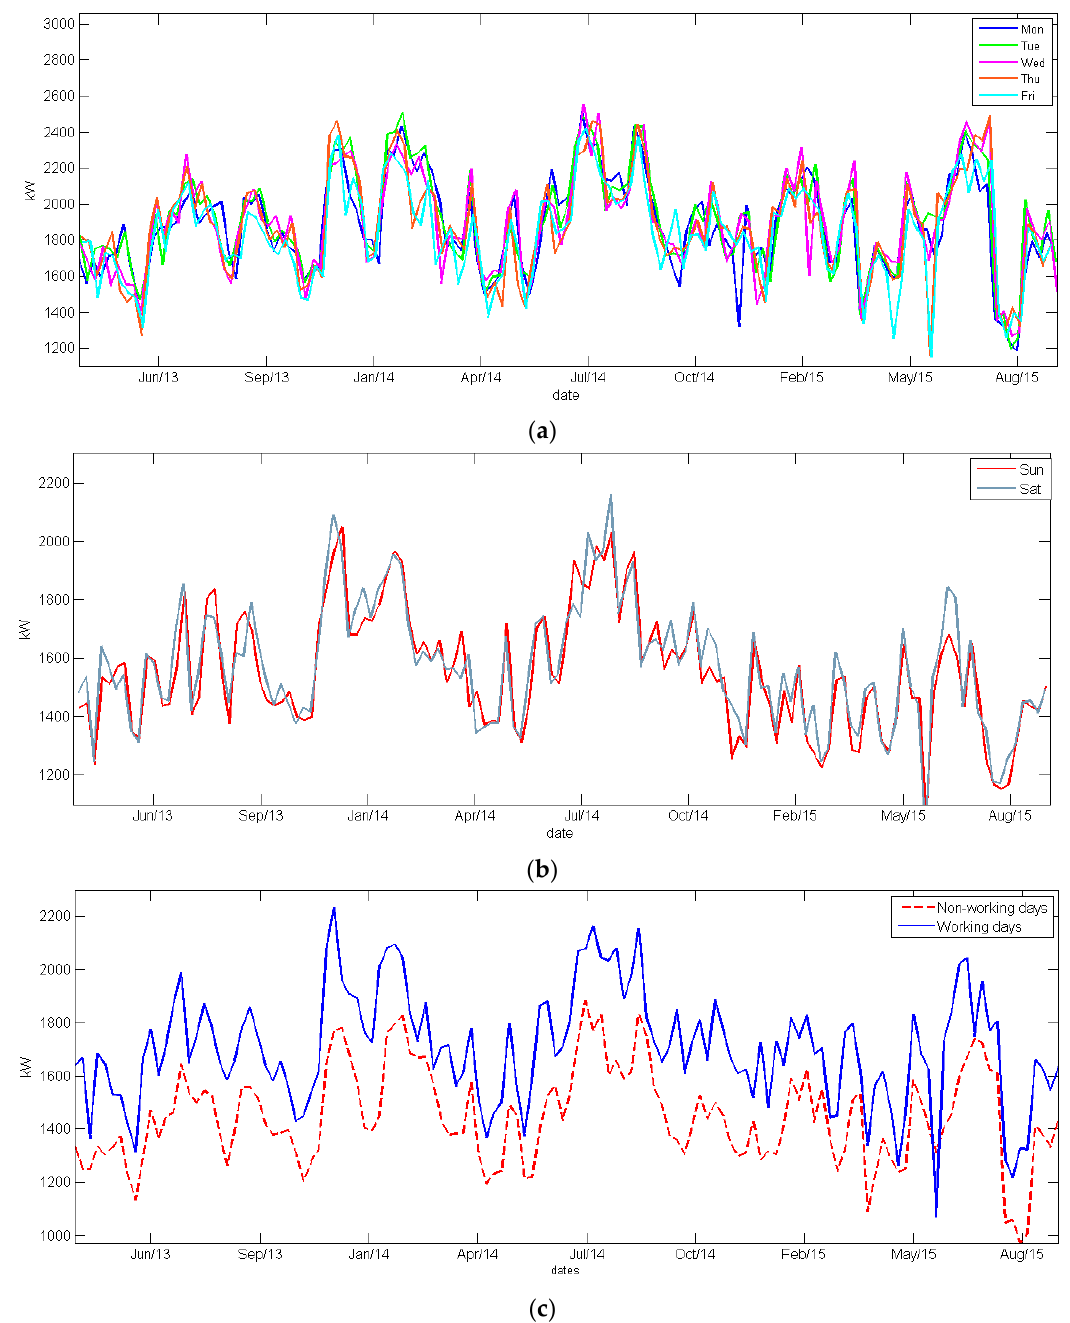
Figure 9. Example of a building’s consumption for every day of the week. The first graph ( a ) shows the registered consumption (kW) of each working day for a two ‐ year period. The second graph ( b ) shows the consumption (kW) during the weekend days. The third graph ( c ) shows a comparison between the average consumption (kW) on working and weekend days, over the same two ‐ year period.